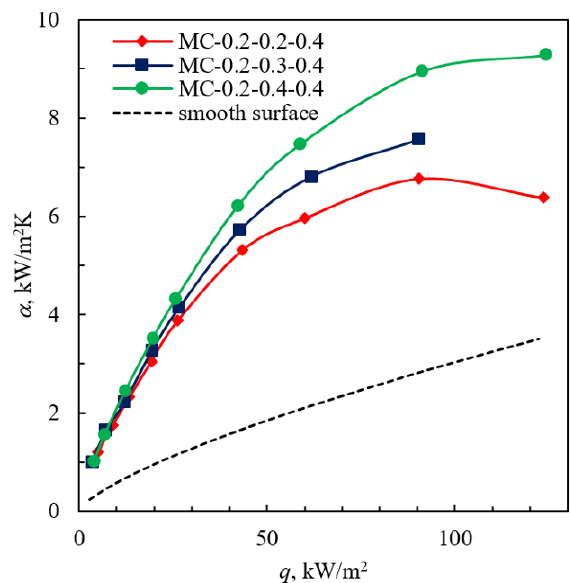
Fig. 5. Boiling curves for FC-72, heat transfer coefficient vs. heat